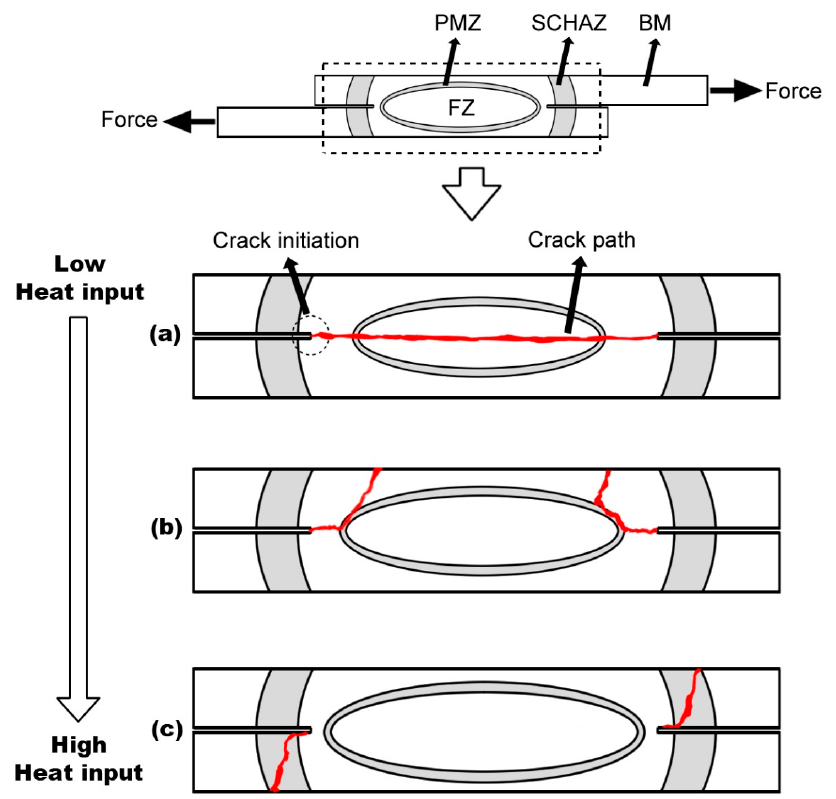
Figure 18. Failure schematic illustration of advanced high strength steel (AHSS): ( a ) Lower heat input; ( b ) middle heat input; ( c ) higher heat